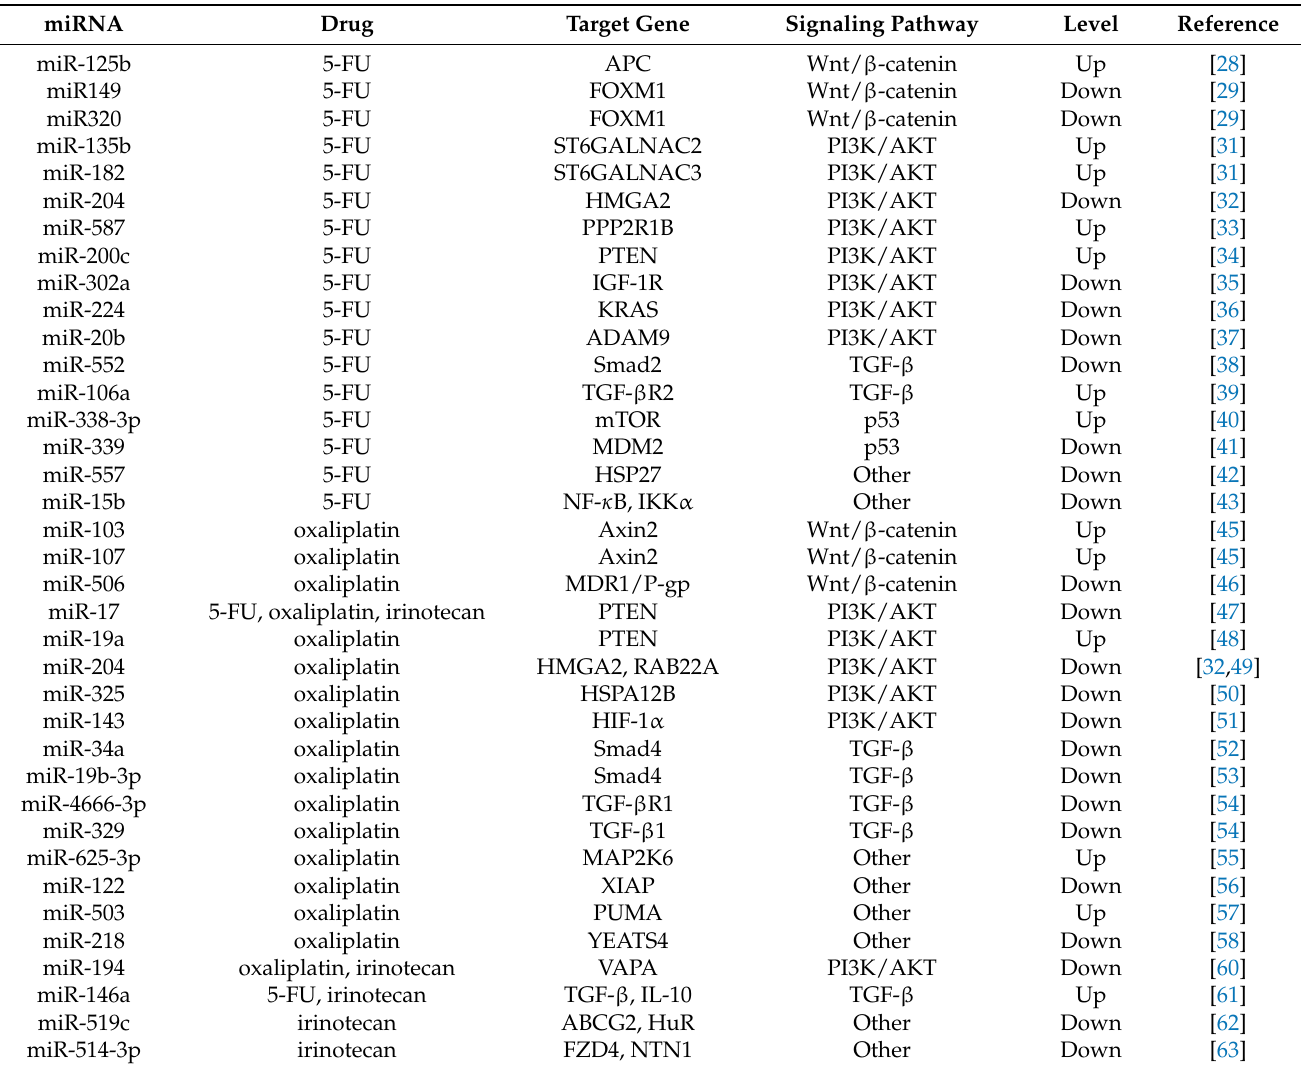
Table 1. MicroRNAs (miRNAs) involved in chemoresistance in colorectal cancer (CRC). miRNA Target